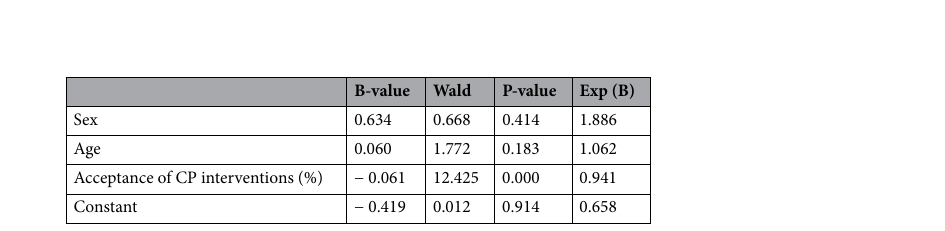
Table 3. Treatment guidelines adherence for antidepressants and antipsychotics ( CP clinical pharmacist, MR medication review).